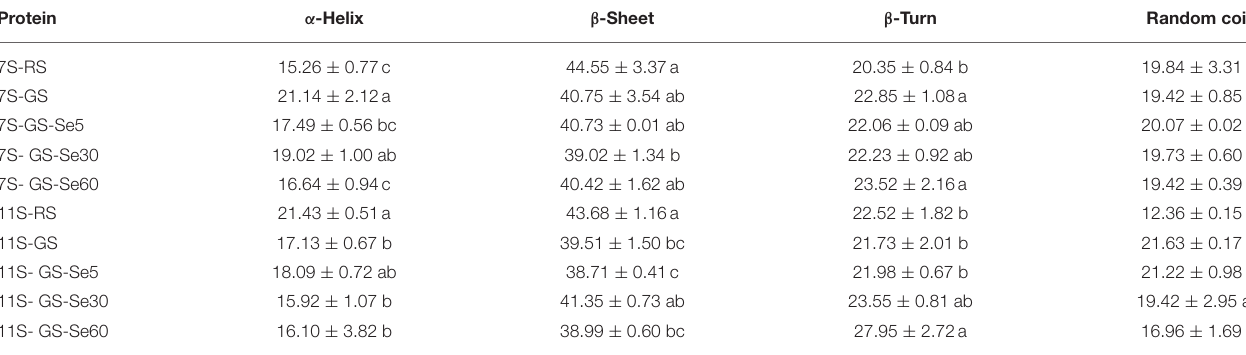
TABLE 3 | Secondary structural compositions of different proteins (%). Protein α -Helix β -Sheet β -Turn Random